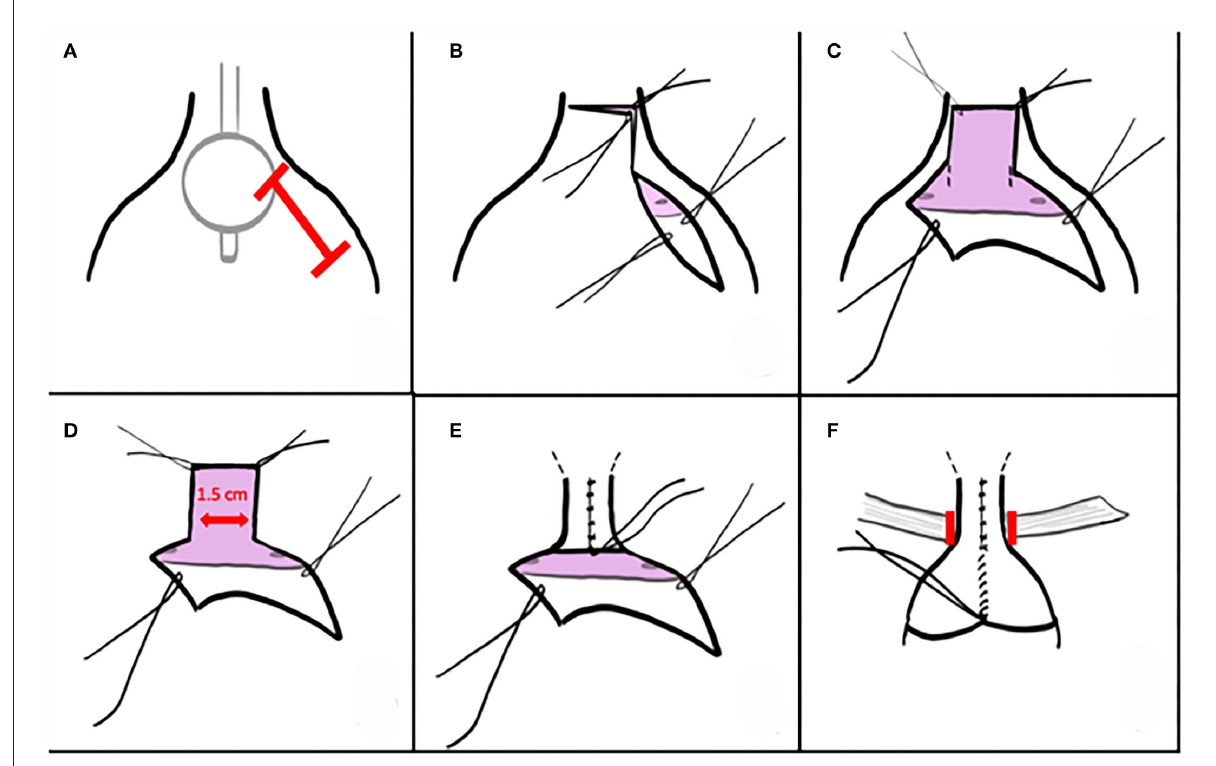
FIGURE1 Described as part of the “Materials and methods”